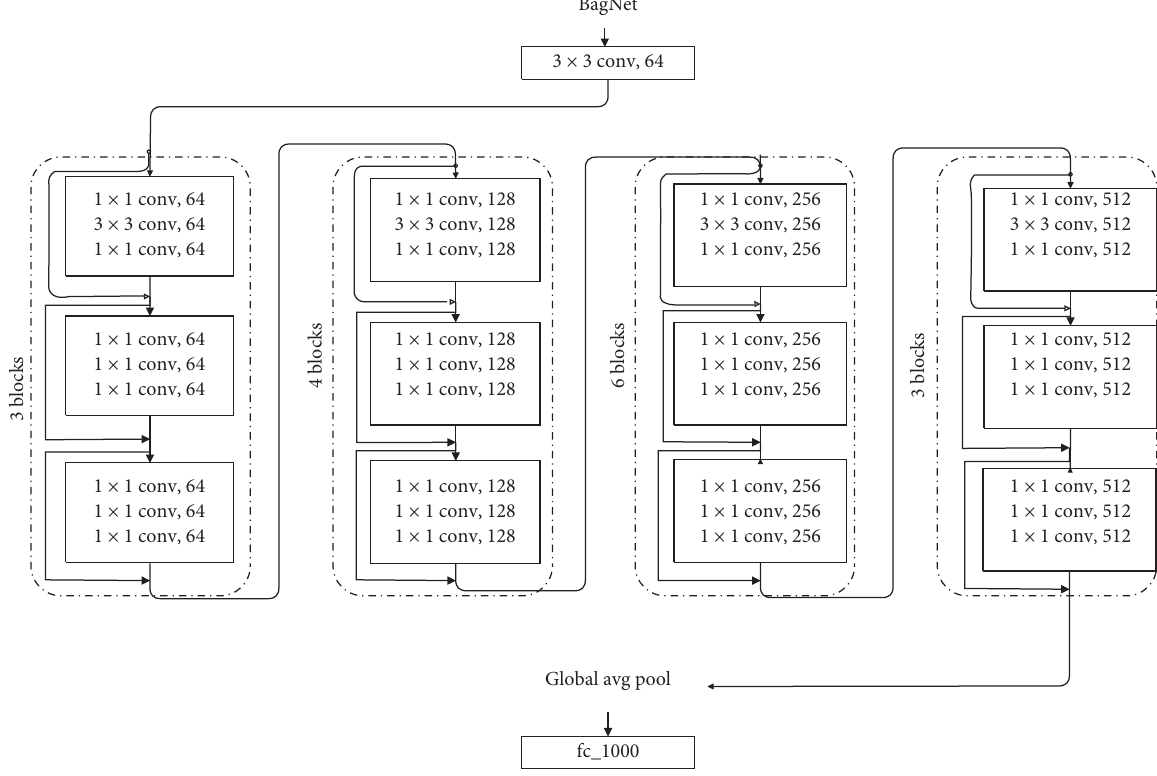
Figure 7: The BagNet architecture is almost equivalent to the ResNet architecture except for a few changes in the strides and the replacement of most 3 × 3 convolutions with 1 × 1 convolutions (the dotted arrow shows the direction of the training process)